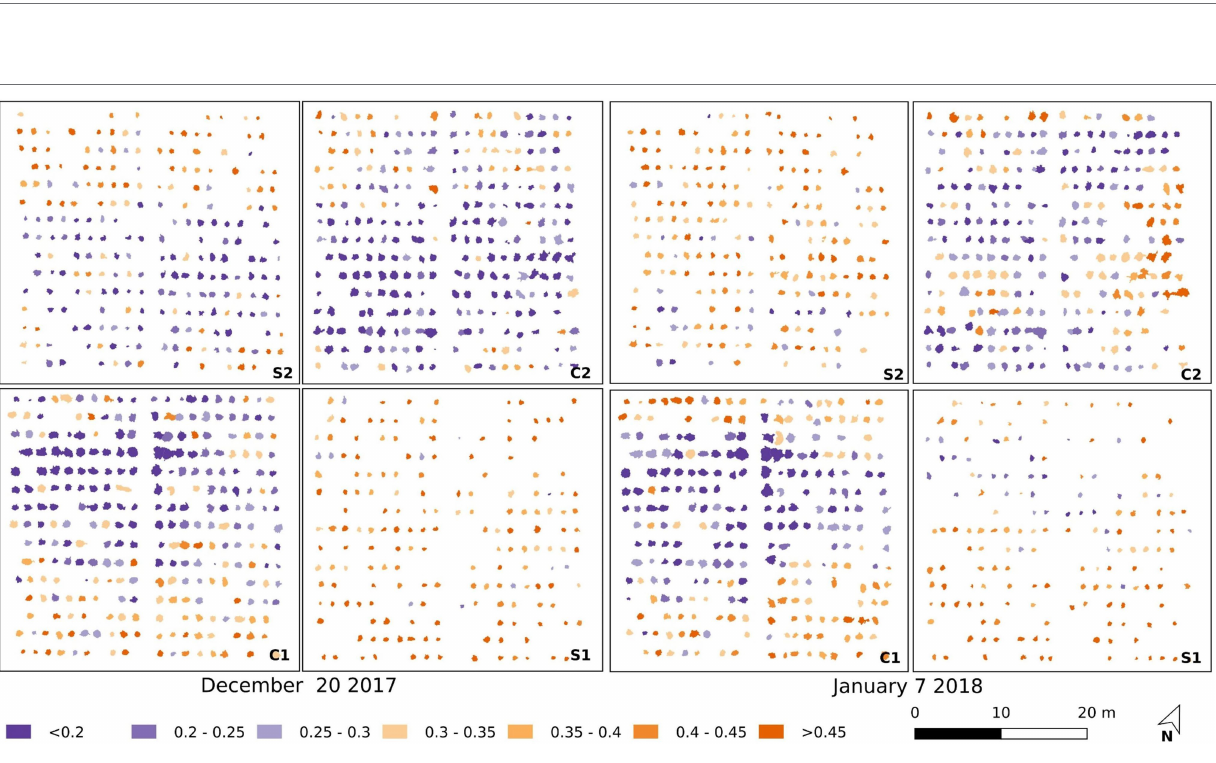
FIGURE 9 | Maps of the CWSIs values for the simplified statistical method in the salt-treated (S1 and S2) and control (C1 and C2) plots for December 20, 2017 (left) , and January 7, 2018 (right)